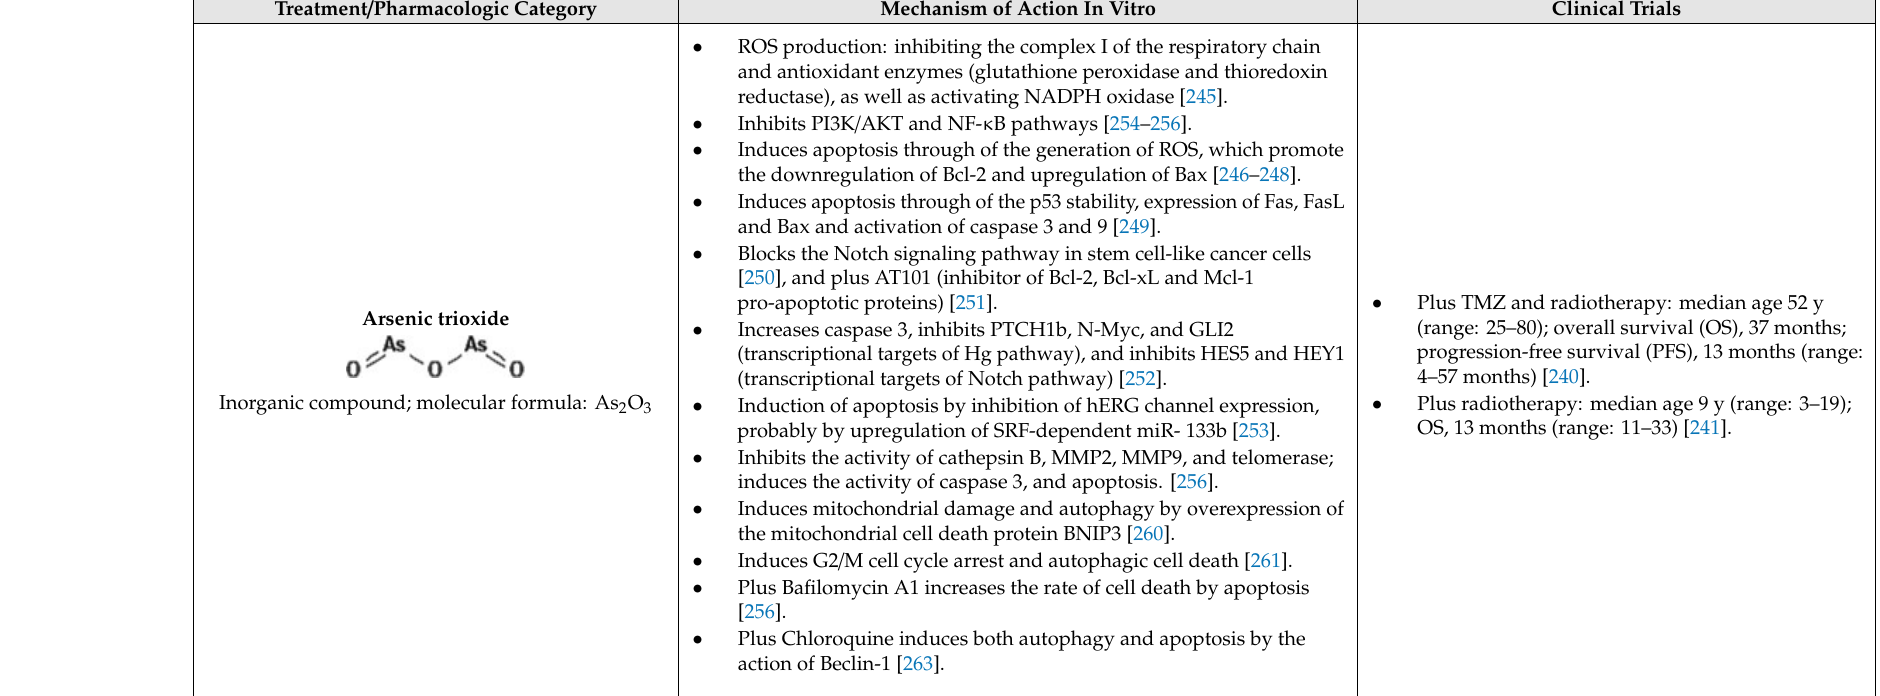
Table 2. Treatment options of autophagic regulators in glioma.